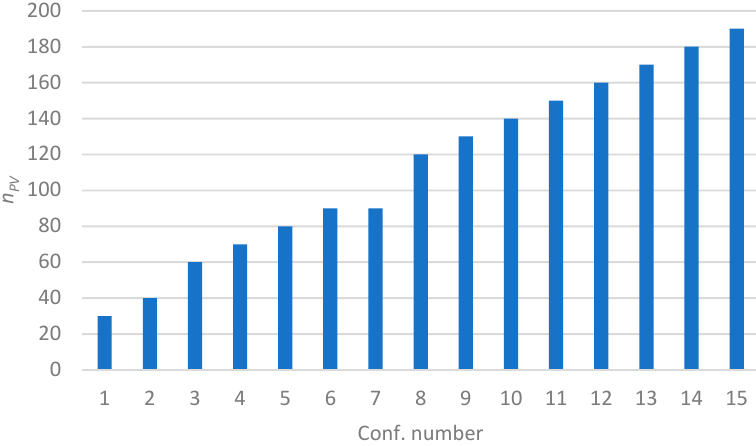
Figure 4. Number of photovoltaic ( PV ) modules for the configurations on the Pareto Frontier.